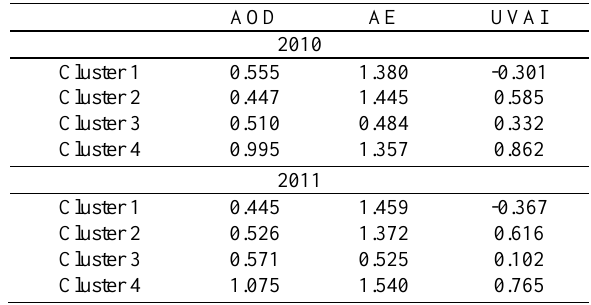
Table 1. The center of each cluster in 2010 and 2011